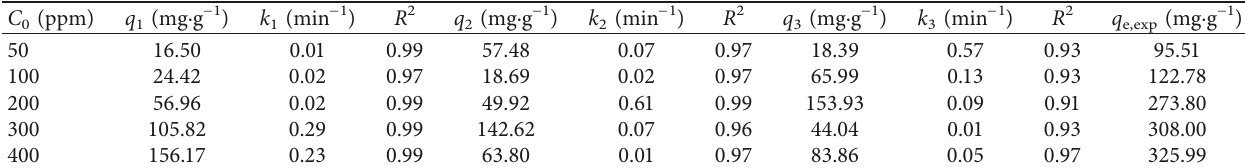
Table 5: Kinetic parameters of three-nonlinear-segment regression for pseudo-first-order kinetic model of RDB adsorption on MIL-101. C 0 (ppm)